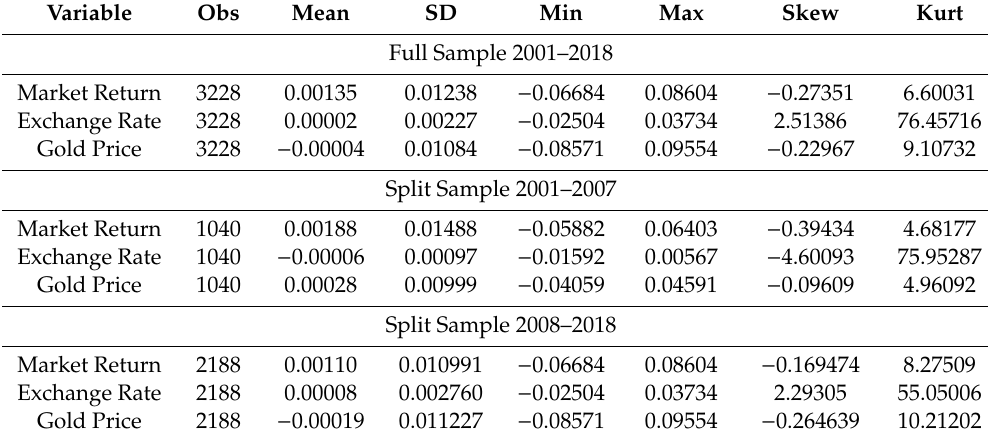
Table 1. Descriptive statistics.